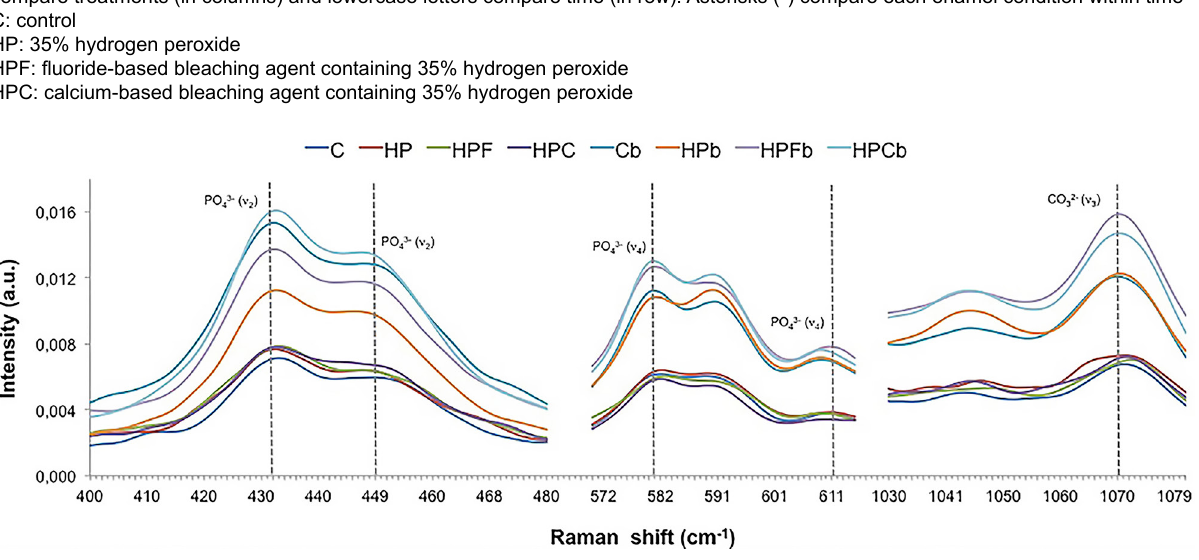
2- ) peak v 3 (1070 cm -1 ) (in arbitrary units) of FT-Raman 3